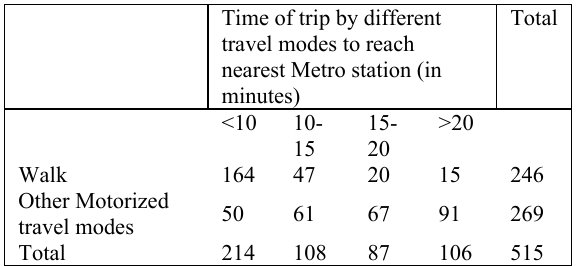
Table 4 . Frequency distribution of Trip time for different travel modes to access the metro station.